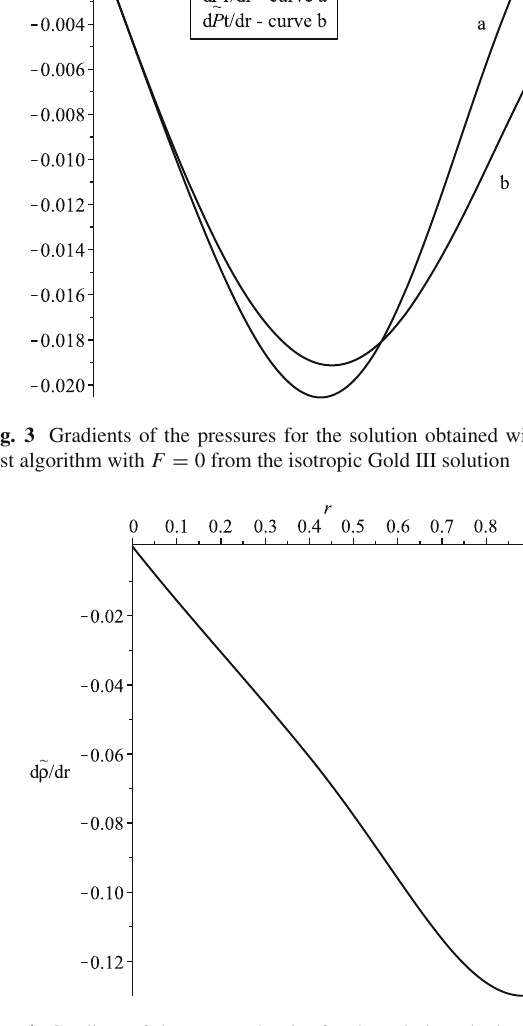
Fig. 2 Energy density for the solution obtained with the first algorithm with F = 0 from the isotropic Gold III solution